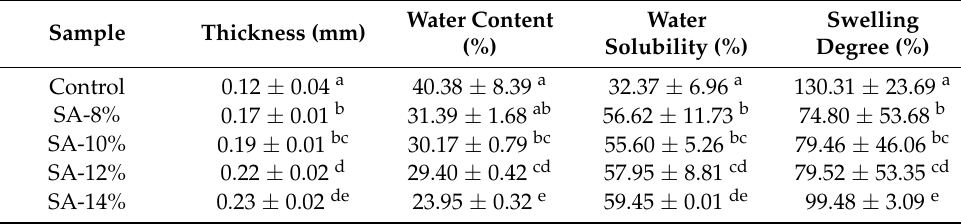
Table 3. Thickness, water content, water solubility, and swelling of